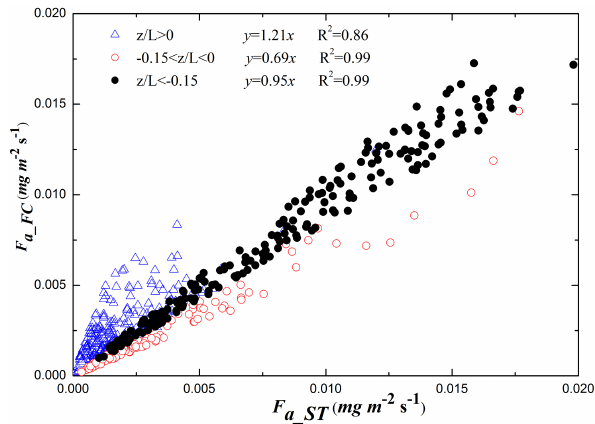
Figure 7. Comparison of aerosol mass fluxed based on the ba- sis of similarity theory (ST) and the free convection (FC) ap- proximation under three different stability conditions ( z/L < − 0.15, − 0.15< z/L <0 and z/L